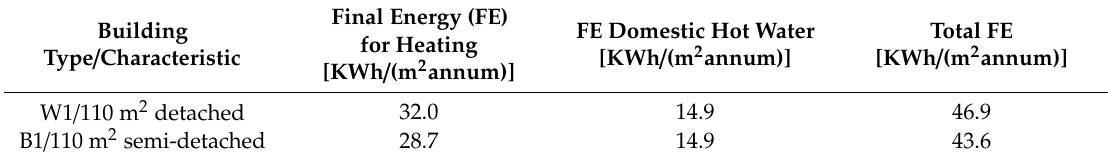
Figure 7. Yearly energy consumption for heating, domestic hot water preparation and lighting in the analysed buildings. B1 (semi-detached building), W1 (detached building). Table 6. Yearly final energy consumption for the analysed